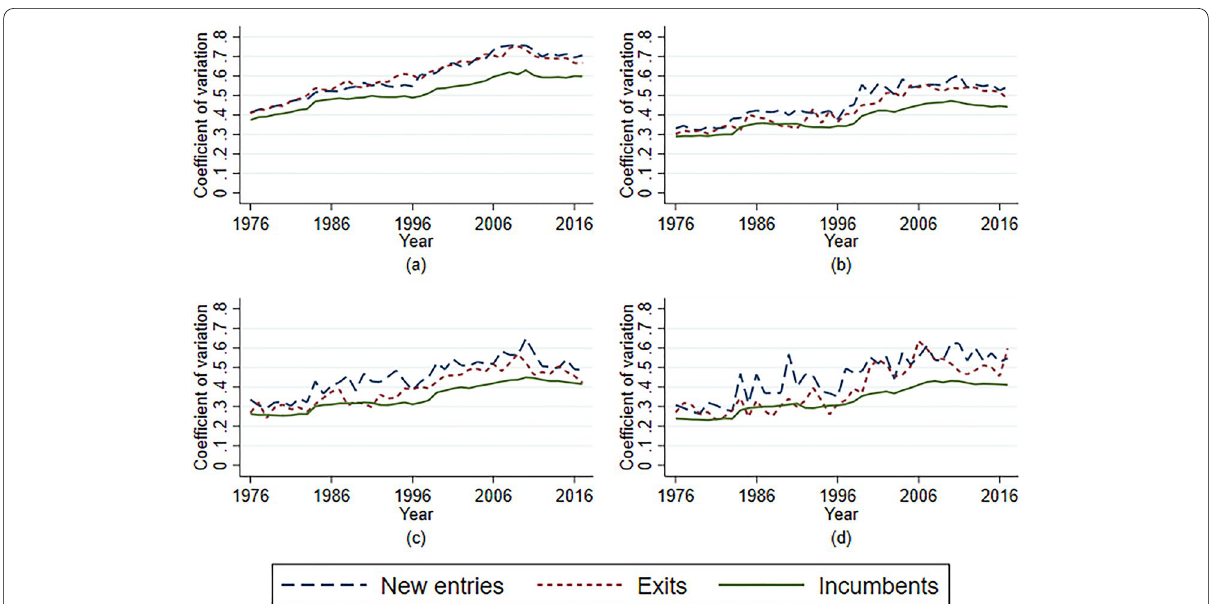
Fig. 15 Coefficient of variation within different establishment size classes for the service sector. a 1–9 employees, b 10–19 employees, c 20–49 employees, d 50 +